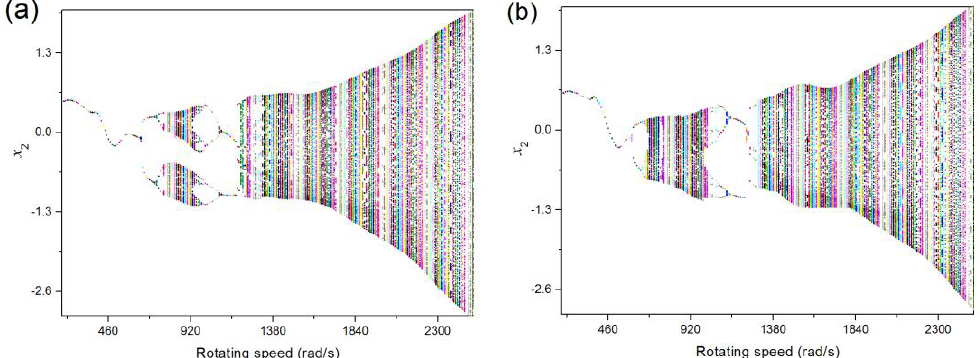
Figure 8. Bifurcations as α = π/3. ( a ) without initial bending, ( b ) with initial bending.